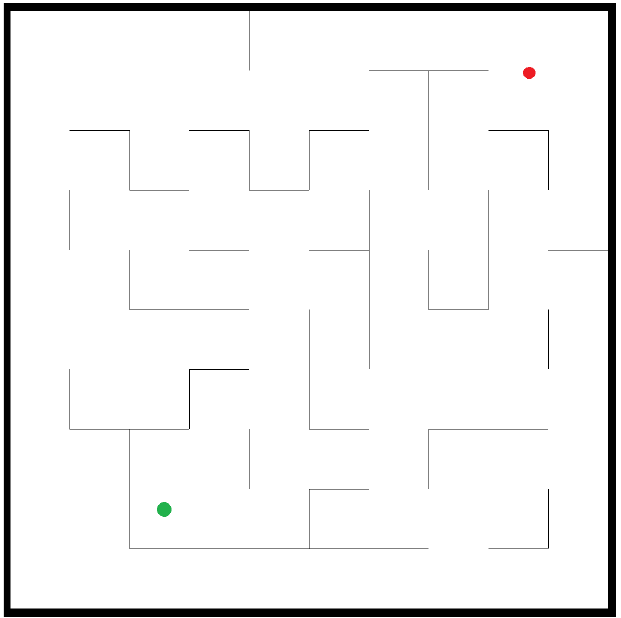
Figure 6. The 2D simulation environment in RoNAP, with the start position, destination position, and obstacles all set randomly. The red dot is the start position and the green dot is the destination